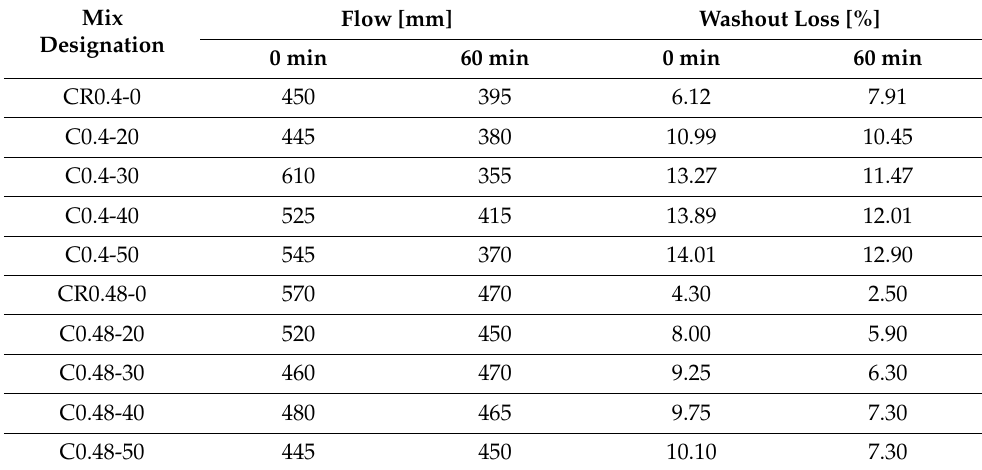
Table 4. Results of UWC mixes’ consistency and wash-out loss testing .